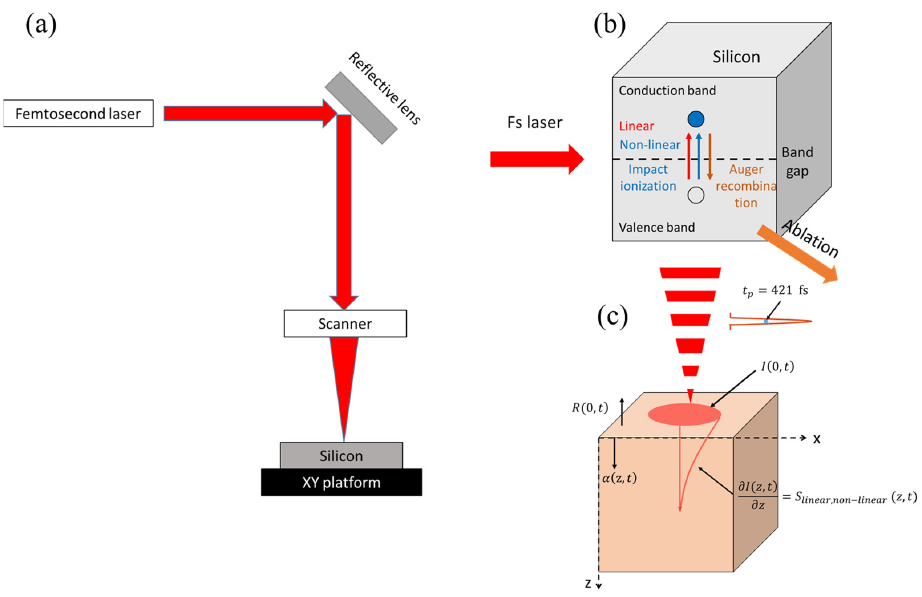
Figure 1. Schematic of the experimental setup and the modeling process: ( a ) the experimental system, ( b ) the light field of the fs laser’s interaction with silicon, and ( c ) the heat field of the fs laser’s interaction with